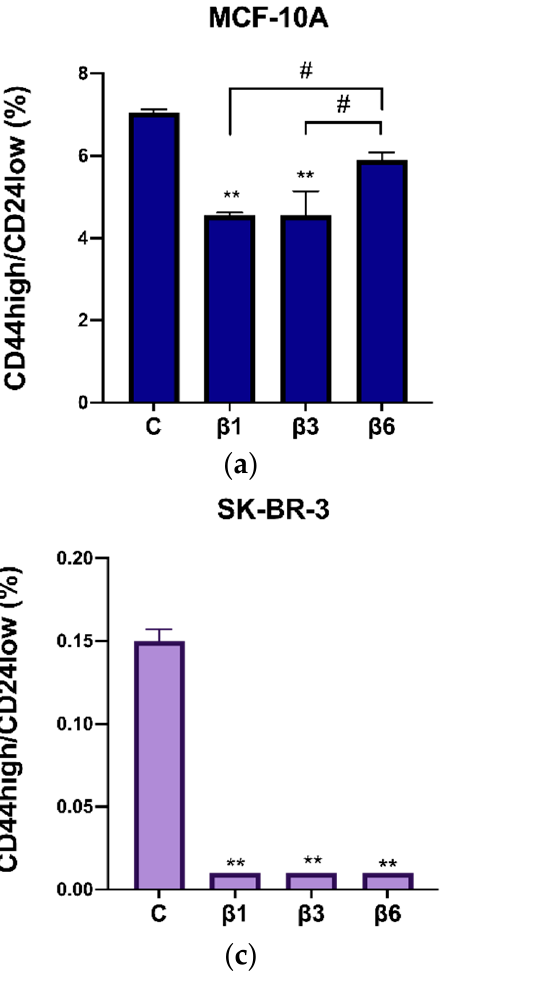
Figure 6. ALDH1 activity after treatment with β 1-conglutin (2.5 ng/µL), β 3-conglutin (5 ng/µL), or